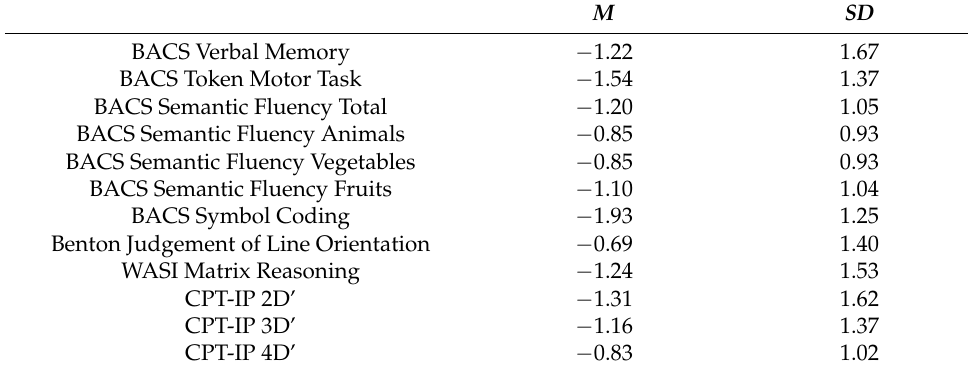
Table 2. Participants’ standardized scores on neurocognitive